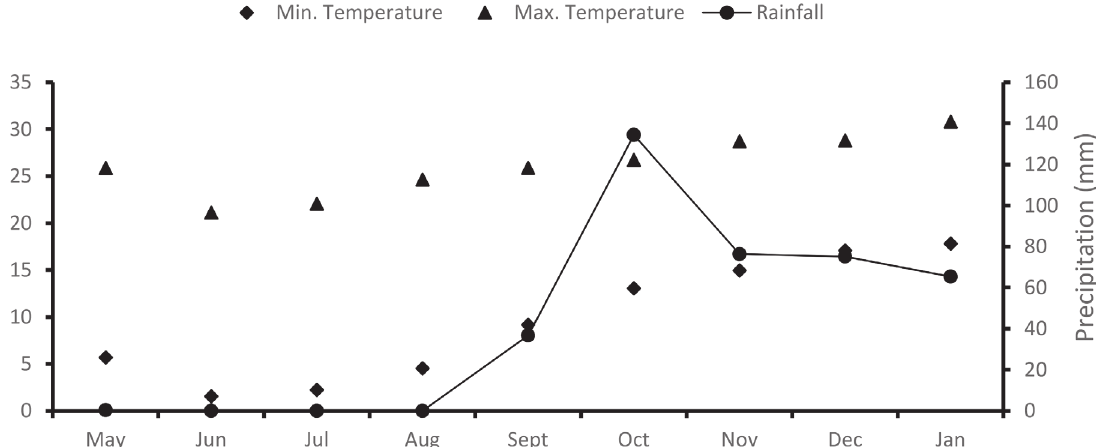
Fig 1. Mean monthly precipitation and minimum and maximum temperatures for 2012 – 2013 at the Agricultural Research Council ’ s Roodeplaat Experimental